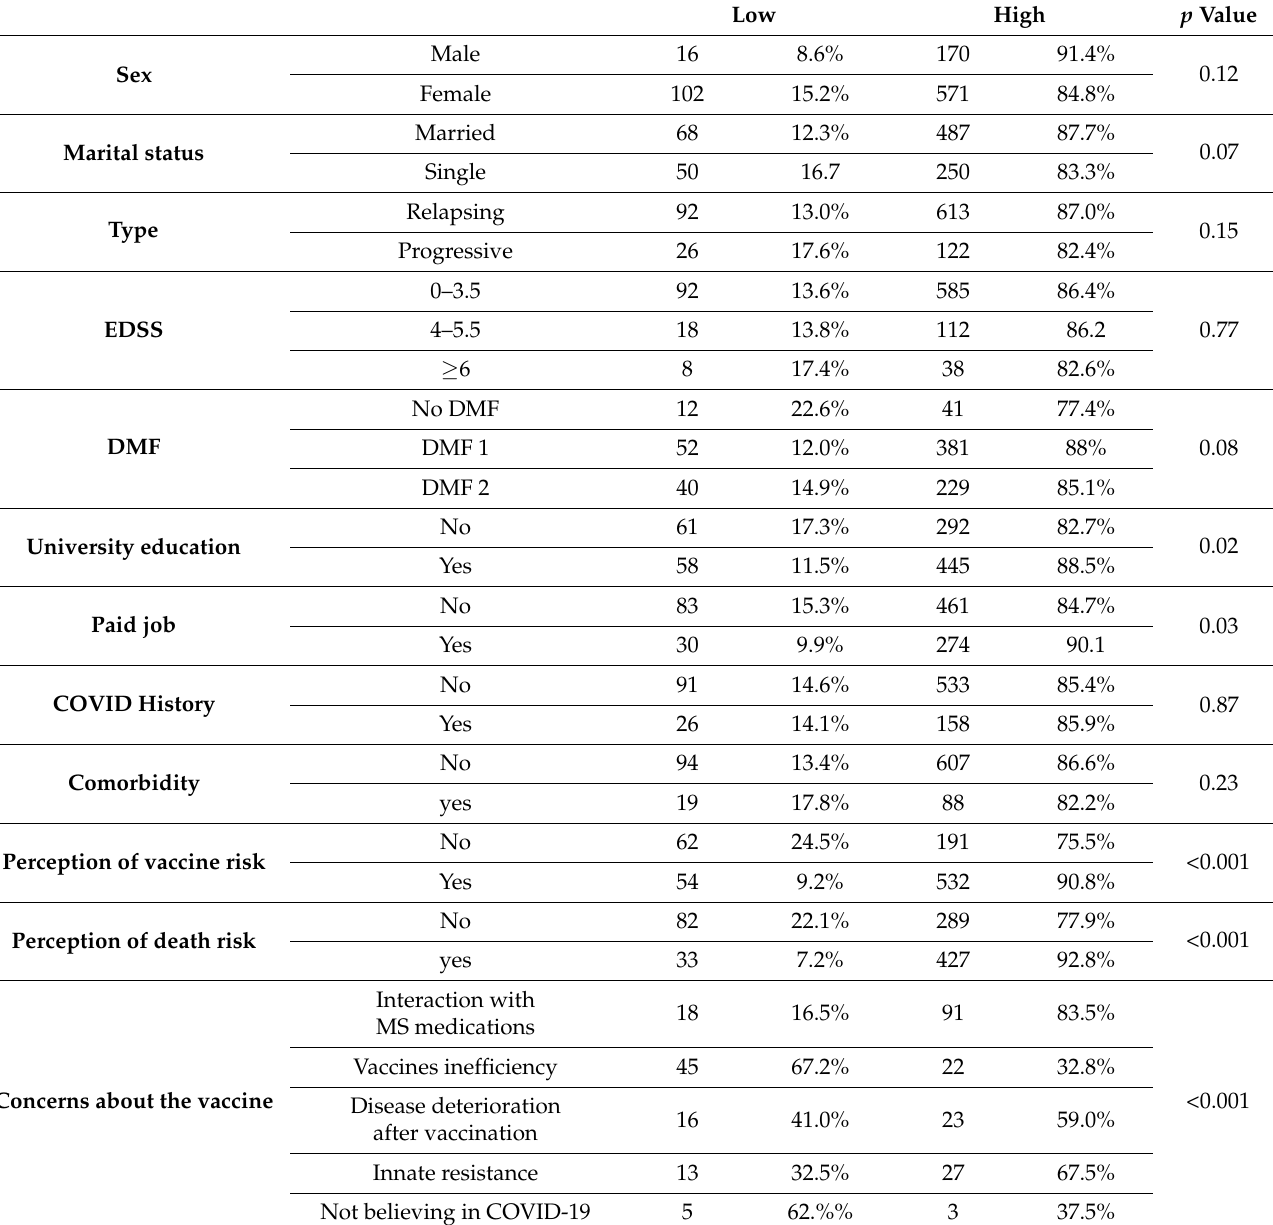
Table 1. Distribution of vaccine willingness based on characteristics of Multiple Sclerosis